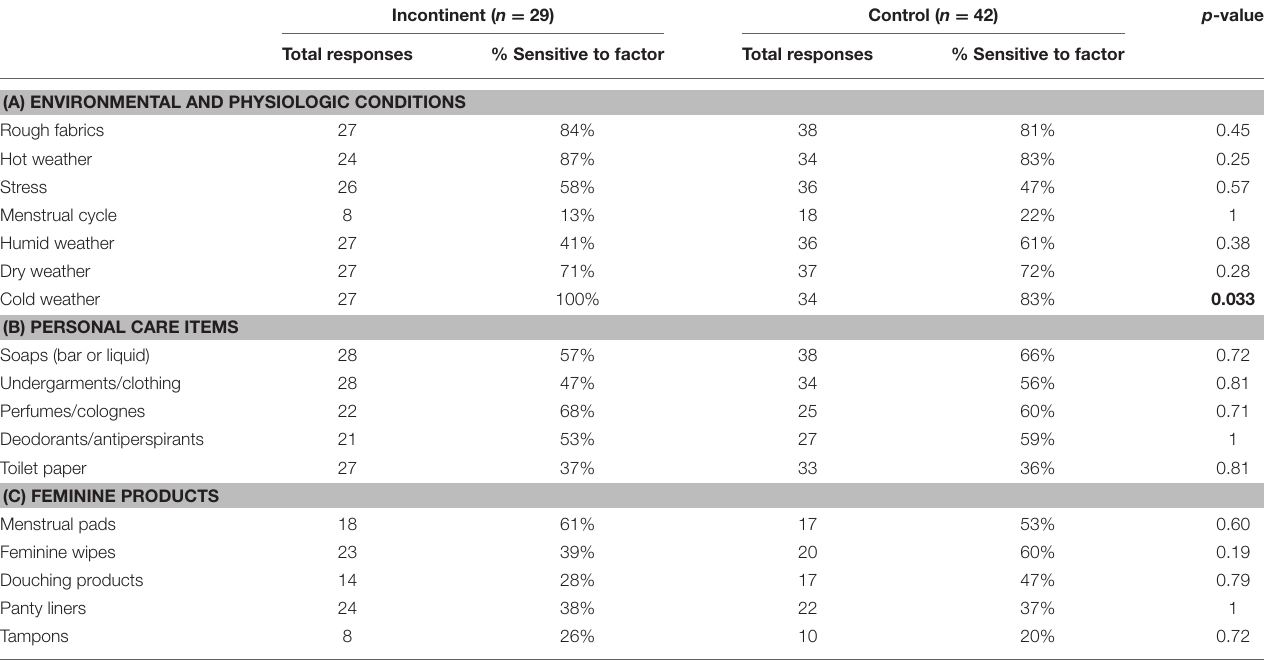
TABLE 4 | Perceptions about skin responses due to relevant external factors among women with